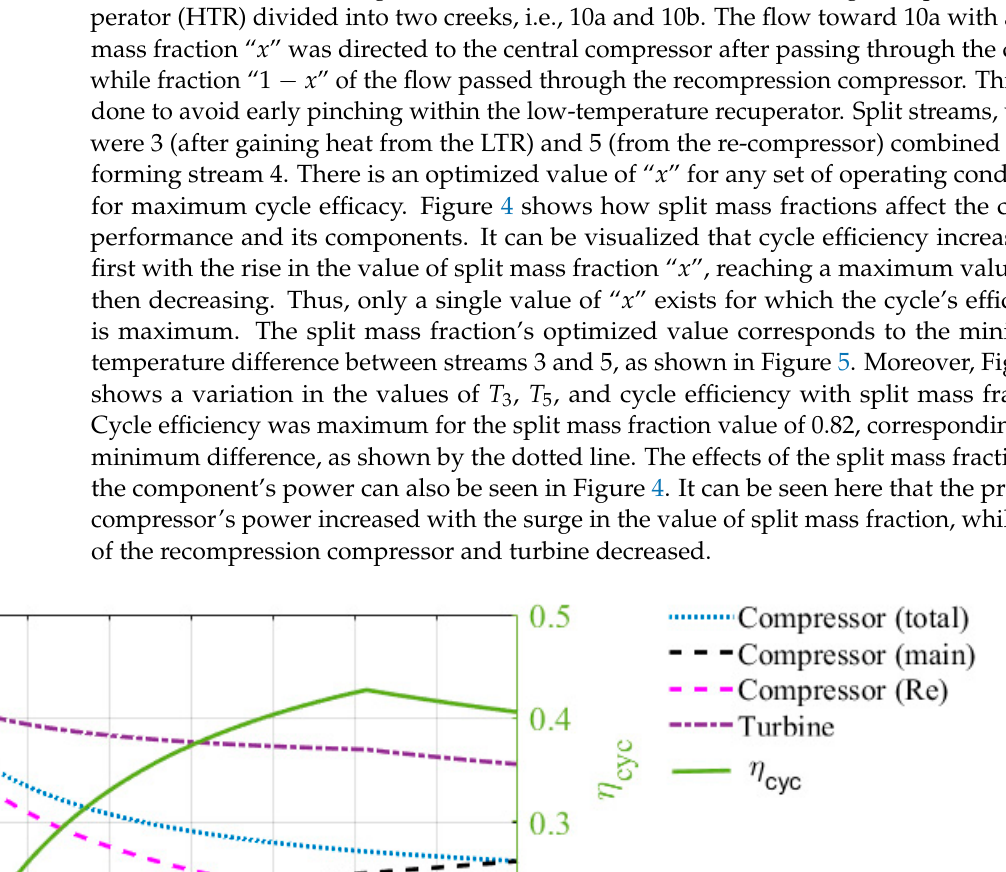
Table 4. Model validation.